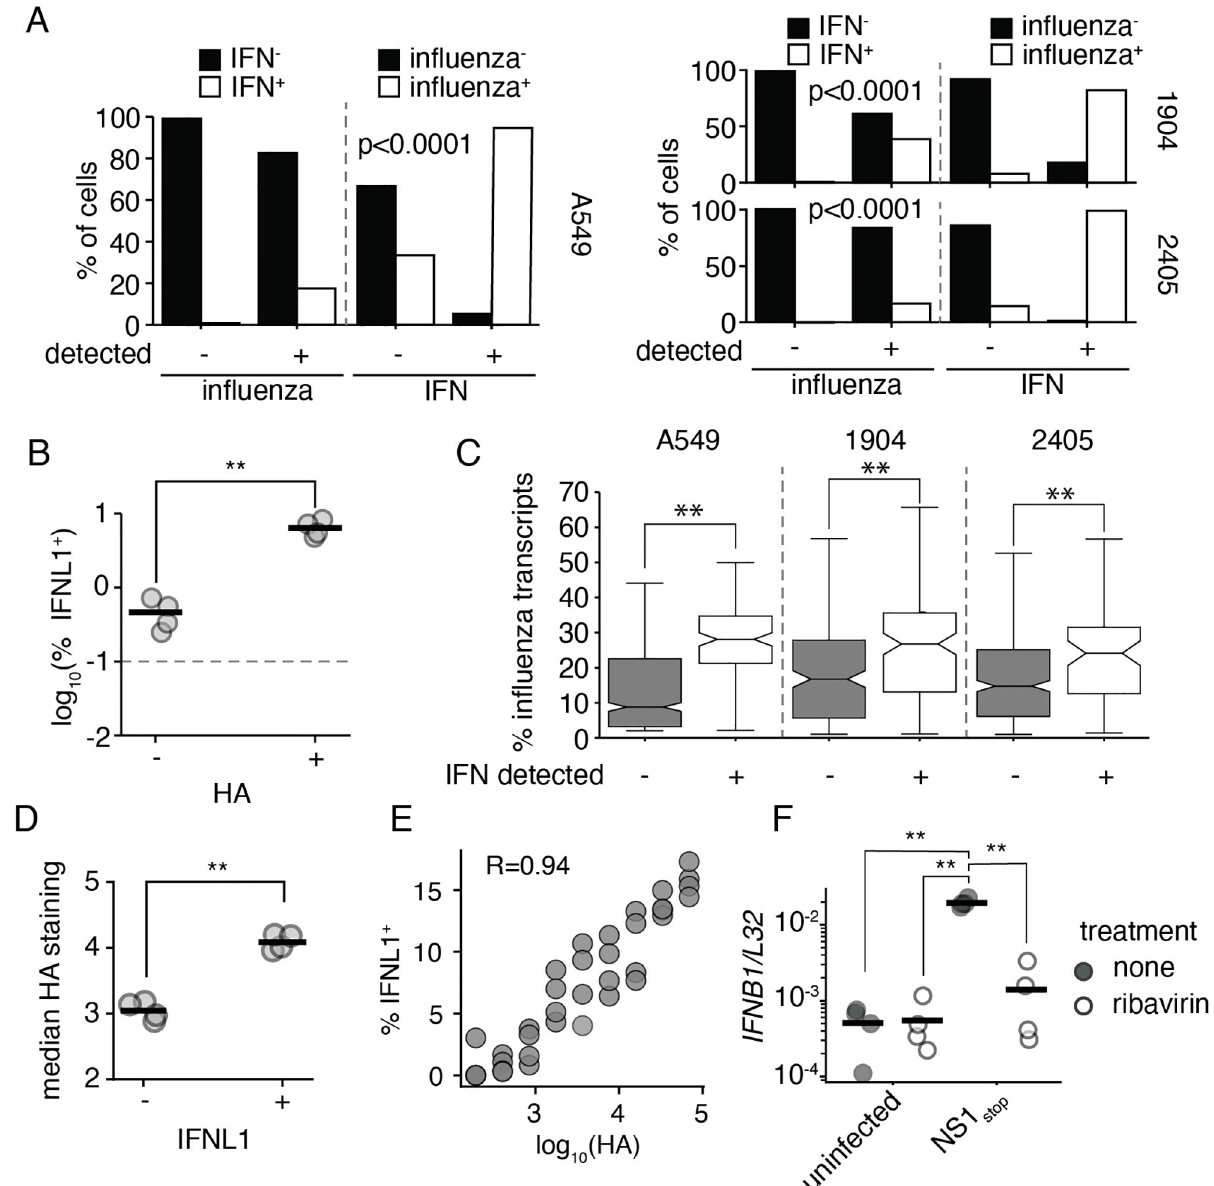
Fig 2. Interferon induction requires active viral replication in an NS1 stop infection. (A) Fraction of cells in our single-cell transcriptomic dataset annotated as positive for either influenza infection or interferon expression were further assessed for expression of interferon or influenza infection, respectively. Each individual single-cell experiment was analyzed seperately, labeled by cell type or donor. Influenza infection and interferon were associated at levels unlikely to be driven by chance (Fisher’s exact test, p values shown) across all experiments. (B) A549 IFNL1 reporter cells were infected with NS1 stop at an infectious MOI of 0.1, fixed, stained for viral HA 13hpi, and analyzed by flow cytometry. HA positive cells are significantly more likely to express the IFNL1 reporter, two-tailed t test, p < 0.01. The dotted line indicates the detection limit as set on an uninfected control. Individual replicates shown, n = 4. Full staining and gates in S9 Fig. (C) Percentage of total transcripts derived from any influenza segment in infected cells seperated by whether interferon (IFN) expression was detected across all single-cell experiments analyzed. Significantly different values were found within each dataset, two-tailed t test, p < 0.001. (D) Analysis of data from B , comparing median HA staining in IFNL1-reporter positive and negative populations. Significantly higher staining was associated with interferon production, two-tailed t test, p < 0.01. (E) Analysis of data from B , comparing the frequency of interferon reporter expression in increasing bins of HA staining. HA staining and probability of interferon expression are positively correlated, R is the Spearman correlation coefficient. (F) A549 cells were treated for two hours with 200 μ M ribavirin prior to infection with the indicated virus at an MOI of 0.2. IFNB1 transcript levels were measured relative to a housekeeping control ( L32 ) 8hpi. Asterisks indicate significant differences, ANOVA p < 0.05, post hoc Tukey’s test, q < 0.05. n = 4. Effect of ribavirin on viral replication and transcription was confirmed by qPCR against viral HA transcripts, as well as the applicability of this phenomenon to CA/04/2009 H1N1 S10 Fig.